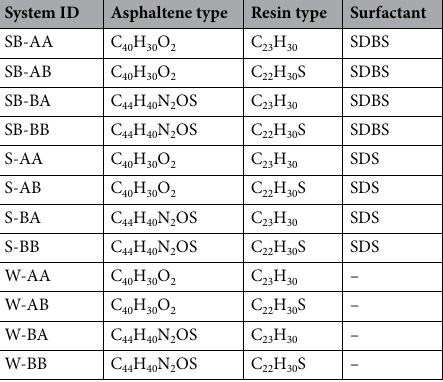
Table 2. Details of MD simulation systems.